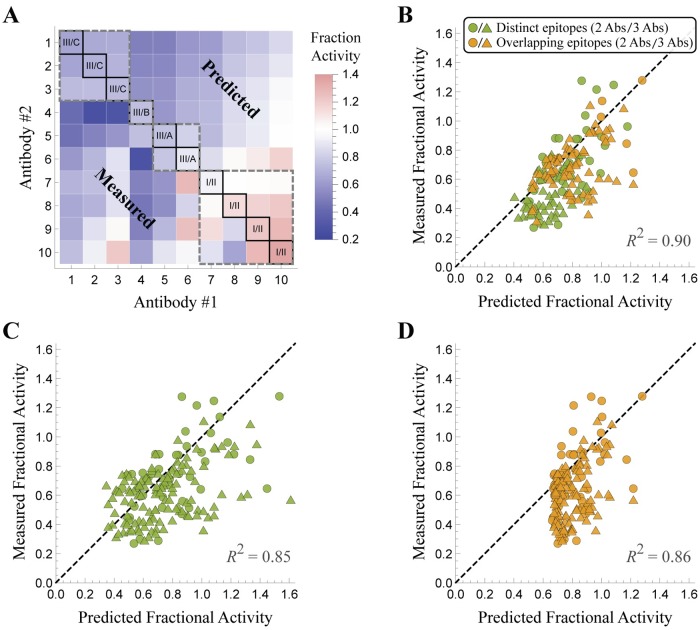
Predicting how antibody mixtures affect the epidermal growth factor receptor (EGFR).(A) The fractional activity of EGFR in the presence of monoclonal antibodies (diagonal) together with the measured (bottom-left) and predicted (top-right) activity of all 2-Ab combinations. The dashed gray boxes enclose antibody pairs that compete for the same epitope while all other pairs bind independently. (B) The predicted versus measured fractional activity for all 2-Ab (circles) and 3-Ab mixtures (triangles) using the same epitope mapping as in Panel A inferred by SPR. Without the epitope map, the activity of the mixtures could alternately be predicted by assuming that all antibodies either (C) bind independently or (D) compete for the same epitope; in either case, the resulting predictions fall further from the diagonal line, indicating poorer predictive power. Data was digitized from Table.1 and Fig S1 of Ref. [6].